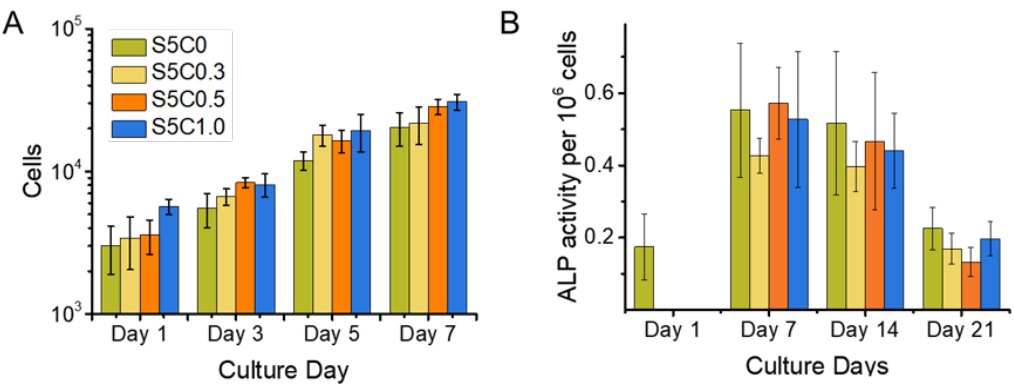
Figure 5. Cell Proliferation and alkaline phosphatase (ALP) Expression. ( A ) Cell proliferation of MC3T3 cells on hydrogel and control sample scaffolds during a time span of 7 days. Cell number is shown in logarithmic scale ( B ) ALP activity of MC3T3 cells cultured on hydrogel (S5C1, S5C0.5, S5C0.3) and control (S5C0) samples over a time span of 3 weeks. Cell proliferation was observed simultaneously with the same experimental set up in order to obtain cell numbers for normalization of measured ALP activity.